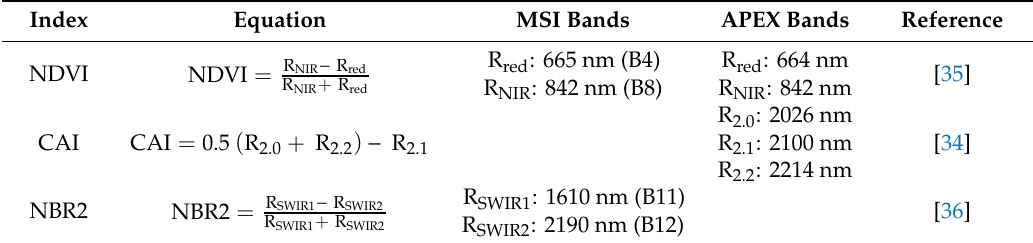
Table 2. Details of derived indices and the wavelengths (nm) used in this work for the Multispectral Instrument (MSI) on board the Sentinel-2 constellation and the Airborne Prism Experiment (APEX) sensor. R: reflectance of specific wavelength, NDVI: Normalized Di ff erence Vegetation Index, CAI: cellulose absorption index, NBR2: Normalized Burn Ratio2.